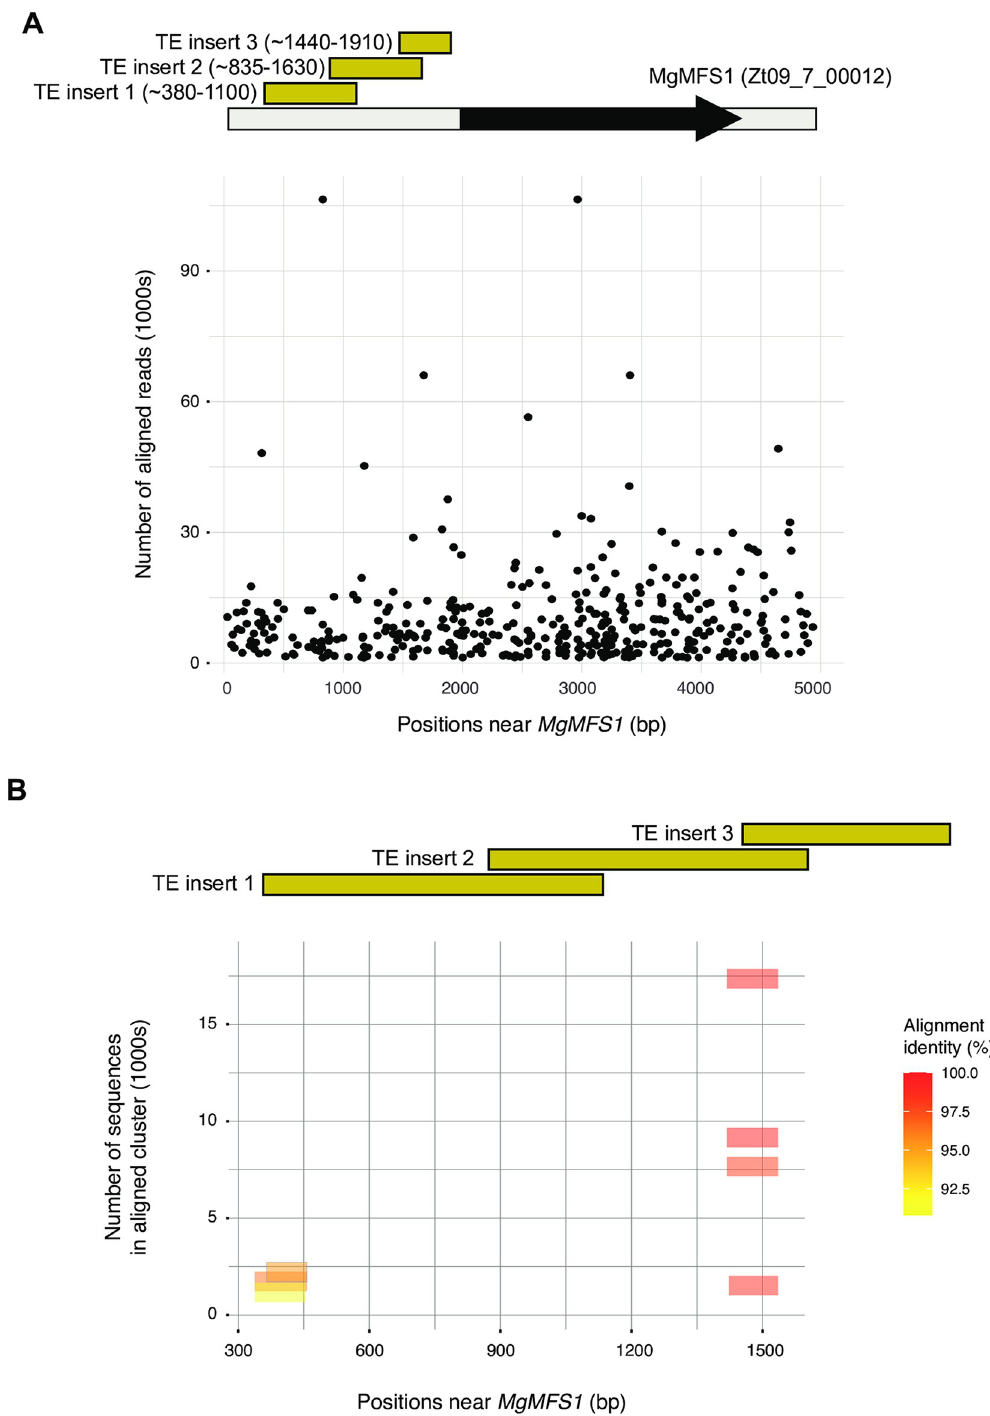
Fig 5. Analyses of amplicons designed on polymorphic transposable element insertions upstream of the multidrug transporter gene MgMFS1 . A) Overview of the location of amplicons designed for each of three transposable element insertion site (1–3). Multiple amplicons were designed for each insertion site. The aligned reads are shown for positions near the coding sequence of MgMFS1 for sample G9 (only positions with > 10 reads mapping are shown). B) After read clustering for sample G9, consensus sequences were blasted against positions near the coding sequence of MgMFS1 . The horizontal bars indicate the extent of a BLASTn alignment with colors indicating the percent identity of the alignment. The vertical position indicates the number of sequences that were clustered for the aligned consensus